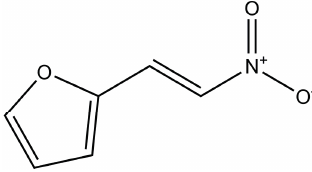
Figure 1. Chemical structure of 2-(2-nitrovinyl) furan